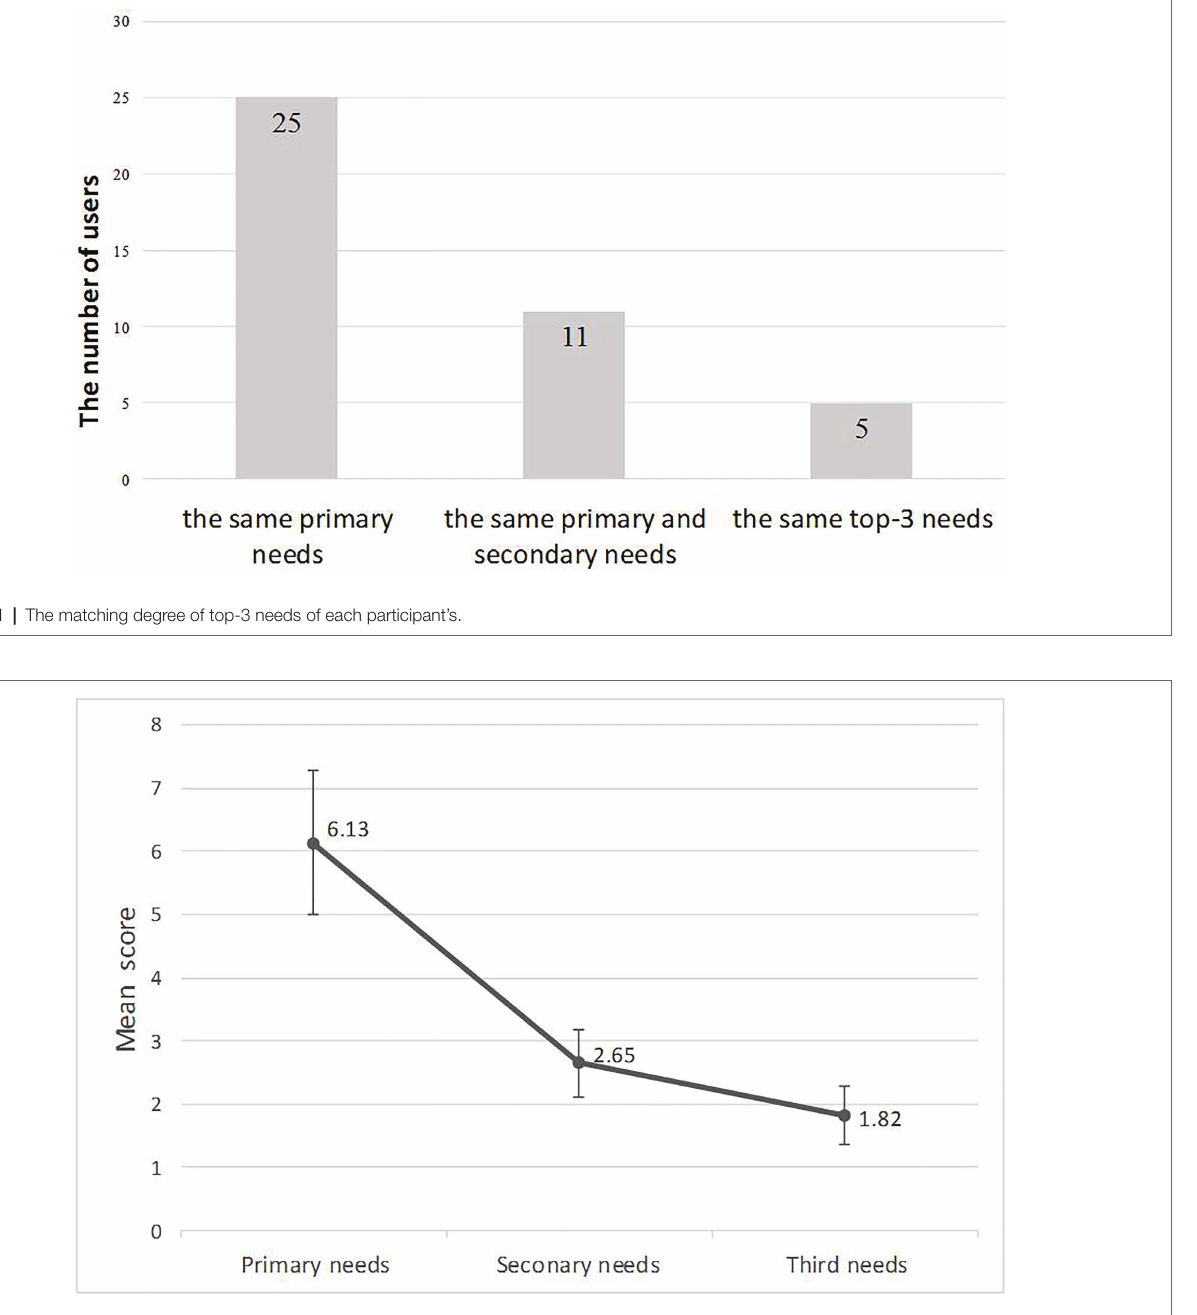
FIGURE 2 | Means of top-3 needs scores of participants based on App usage